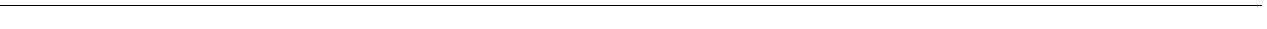
Figure 7 | NuSAP governs Kid-generated PEF during chromosome oscillation. ( a ) Representative images and colour project of MTgliding assay with Kid or NuSAP and Kid proteins. Arrows represent one MT gliding at different time points. Images were acquired in a 2s interval for 5min. Scale bar, 3 m m. ( b ) Kymographs showing a sample microtubule gliding on Kid-coated surfaces in the presence or absence of NuSAP protein. ( c ) Bar chart representing the average velocity of MT gliding on Kid-coated surfaces in the presence or absence of NuSAP protein. Error bars represent ± s.d. * P o 0.01, by t -test. ( d ) Bar chart representing the average of the amplitude (black) and centre velocity (grey) of centromere oscillation in control- or NuSAP/Kid-double- depleted metaphase cells. Error bars represent þ s.e.m. * P o 0.001, by t -test. ( e ) Bar chart representing the average of the amplitude (black) and centre velocity (grey) of centromere oscillation in control- or NuSAP/Kid-double-depleted monopolar cells. Error bars represent þ s.e.m. * P o 0.001, by t -test. ( f ) The kinetochore MTs in metaphase HeLa cells transfected with control siRNA, NuSAP siRNA, GFP-vector or GFP-NuSAP after cold treatment. Cells were stained with an anti- a -tubulin antibody and DNA with Hoechst 33342. Scale bar, 5 m m. ( g ) Representative images of PAGFP a -tubulin stability in metaphase HeLa cells transfected with control siRNA, NuSAP siRNA, mCherry vector or mCherry-NuSAP after photoactivation. Dotted squares represent photoactivated region. Scale bar, 5 m m. ( h ) Bar chart of the half-lives of spindle MTs calculated with a double exponential regression fitting of photoactivation assays. n (control siRNA) ¼ 14 cells, n (NuSAP siRNA) ¼ 13, n (mCherry) ¼ 13, n (mCherry-NuSAP) ¼ 12. Error bars represent ± s.d. ( i ) FRAP assays; representative images of MTdynamics in metaphase stable mCherry- a -tubulin HeLa cells transfected with control siRNA, NuSAP siRNA, GFP-vector or GFP-NuSAP after photobleaching. Dotted squares represent the photobleaching region. Scale bar, 5 m m. ( j ) Dot plot representing the half-life of kinetochore microtubules (slow phase) and interpolar microtubules (fast phase) calculated according to a double exponential regression curve with FRAP assays in control siRNA-, NuSAP siRNA-, GFP-vector- or GFP-NuSAP-transfected metaphase cells. Mean ± s.e.m. are indicated. NATURE COMMUNICATIONS|7:10597|DOI: